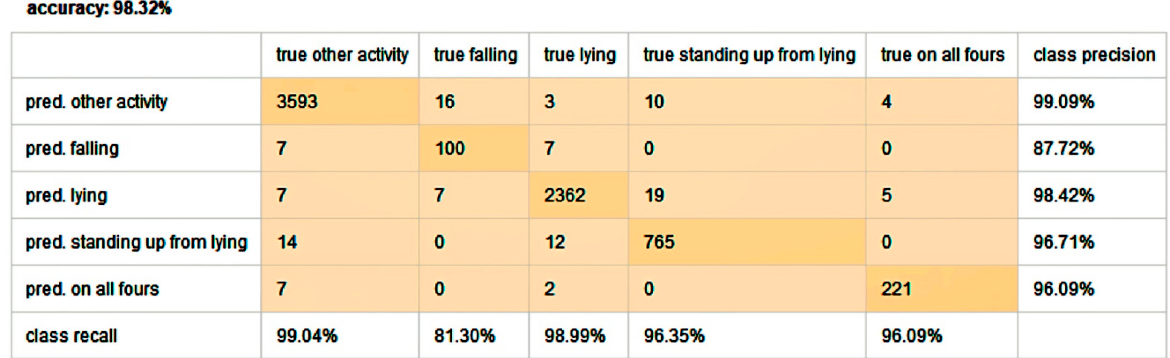
Figure 3. Confusion matrix (tabular view) of the RapidMiner process shown in Figure 2, which is a k-NN-based multilabel machine learning approach for detecting falls and fall-related motions when the first dataset [50] was used.